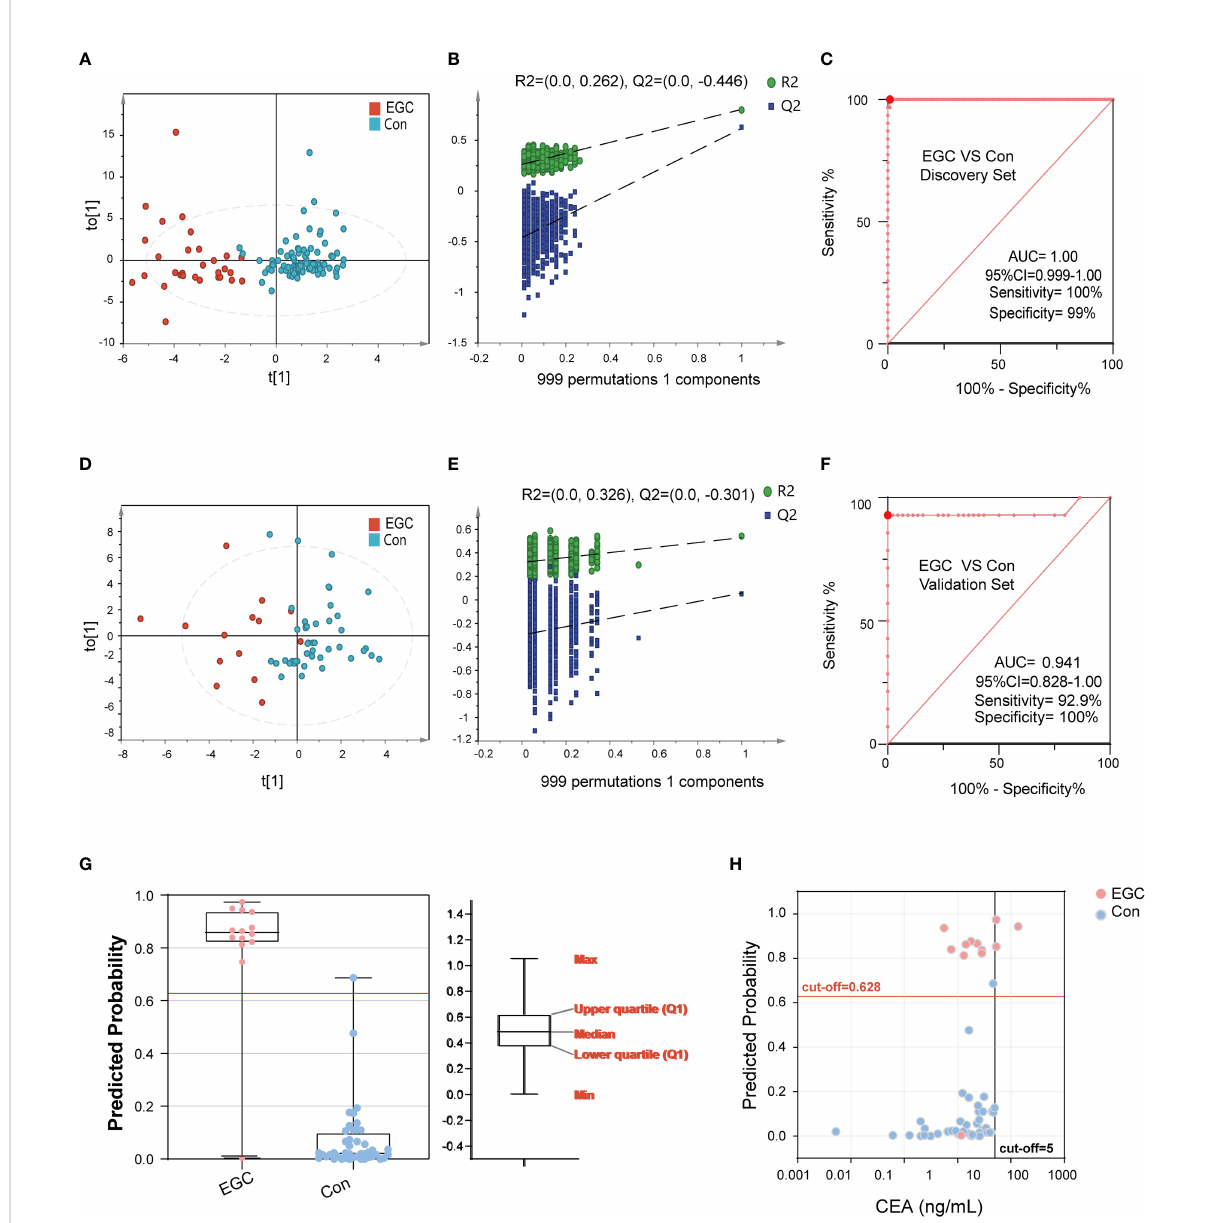
FIGURE 5 The performance of BA biomarkers in distinguishing early GC and Con group. (A) : OPLS-DA score plot of early GC and Con groups in the discovery set. (B) : permutation test result of the above OPLS-DA. (C) : ROC curve of 6-BAs diagnostic panel between early GC and Con group, which was constructed in the discovery set. (D) : OPLS-DA score plot of early GC and Con groups in the validation set. (E) : permutation test result of the above OPLS-DA. (F) : ROC curve of 6-BAs diagnostic panel between early GC and Con group, which was constructed in the discovery set and validation set. (G) : Predicted probability of the 6-BAs diagnostic panel identi fi ed in the discovery set and applied to the validation set. (H) : Scatter plot for comparing the 6-BAs diagnostic panel and